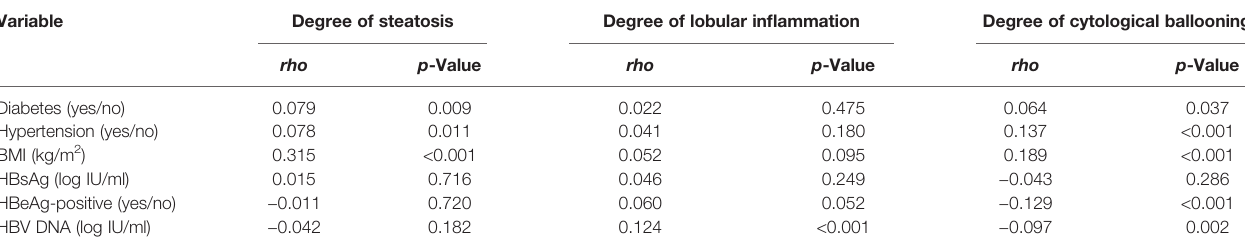
TABLE 4 | Correlation analysis between metabolic, virological factors, and NASH-related histological changes.